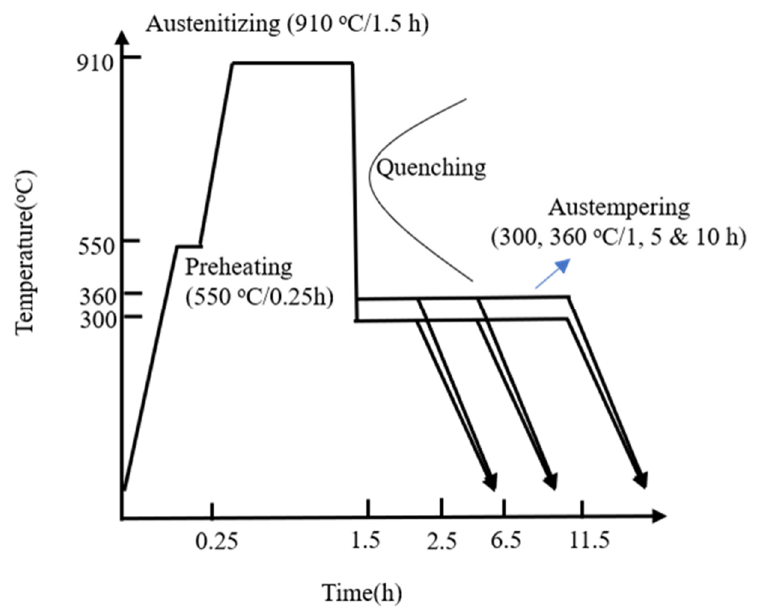
Figure 1. Flowchart of the austempering treatment in the study.